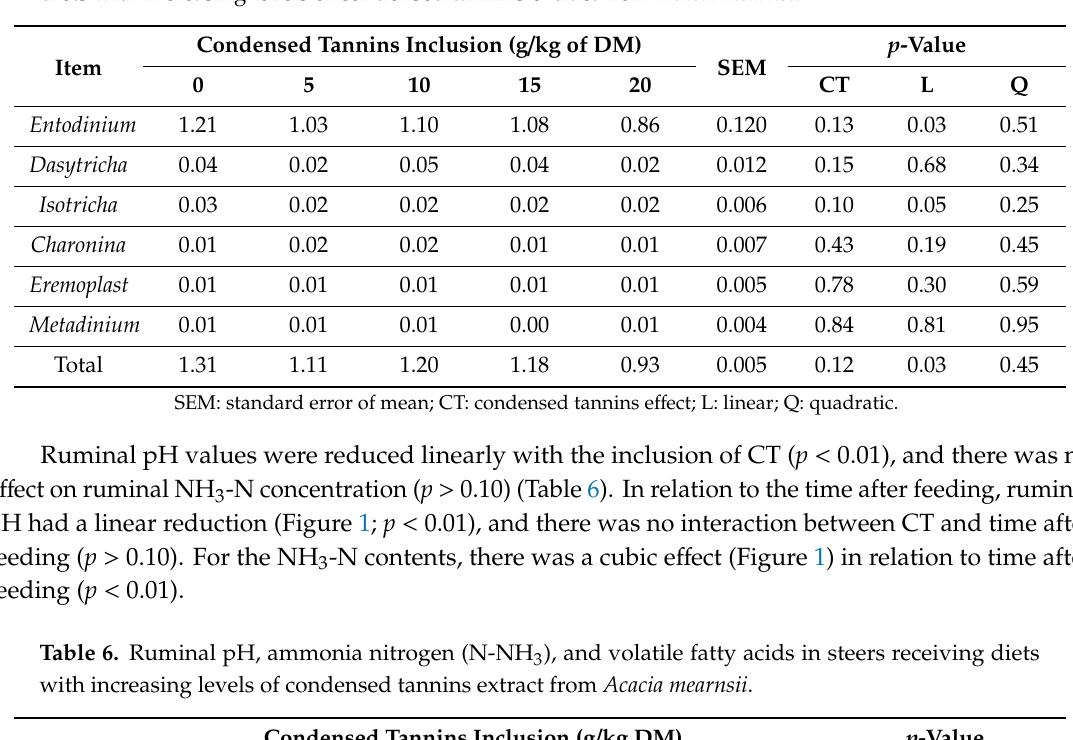
Table 5. Protozoa population in ruminal content ( n × 10 6 / mL of ruminal content) in steers receiving diets with increasing levels of condensed tannins extract from Acacia mearnsii .